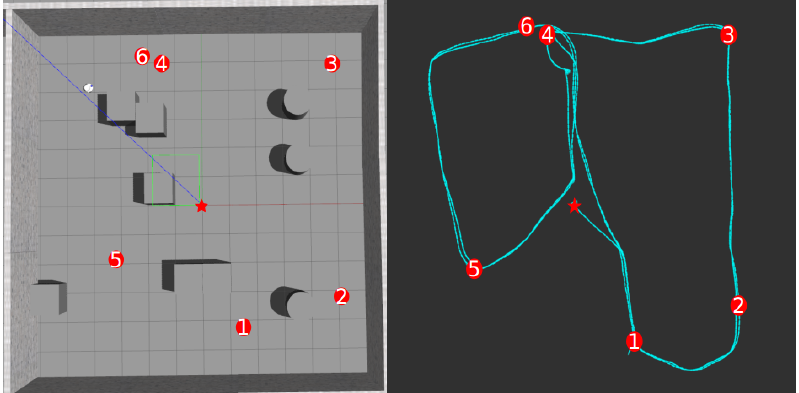
Figure 4. The trajectory of the mobile robot in the single robot mapless navigation tasks. The left part is the navigation environment in Gazebo, the right part is the trajectory of the mobile